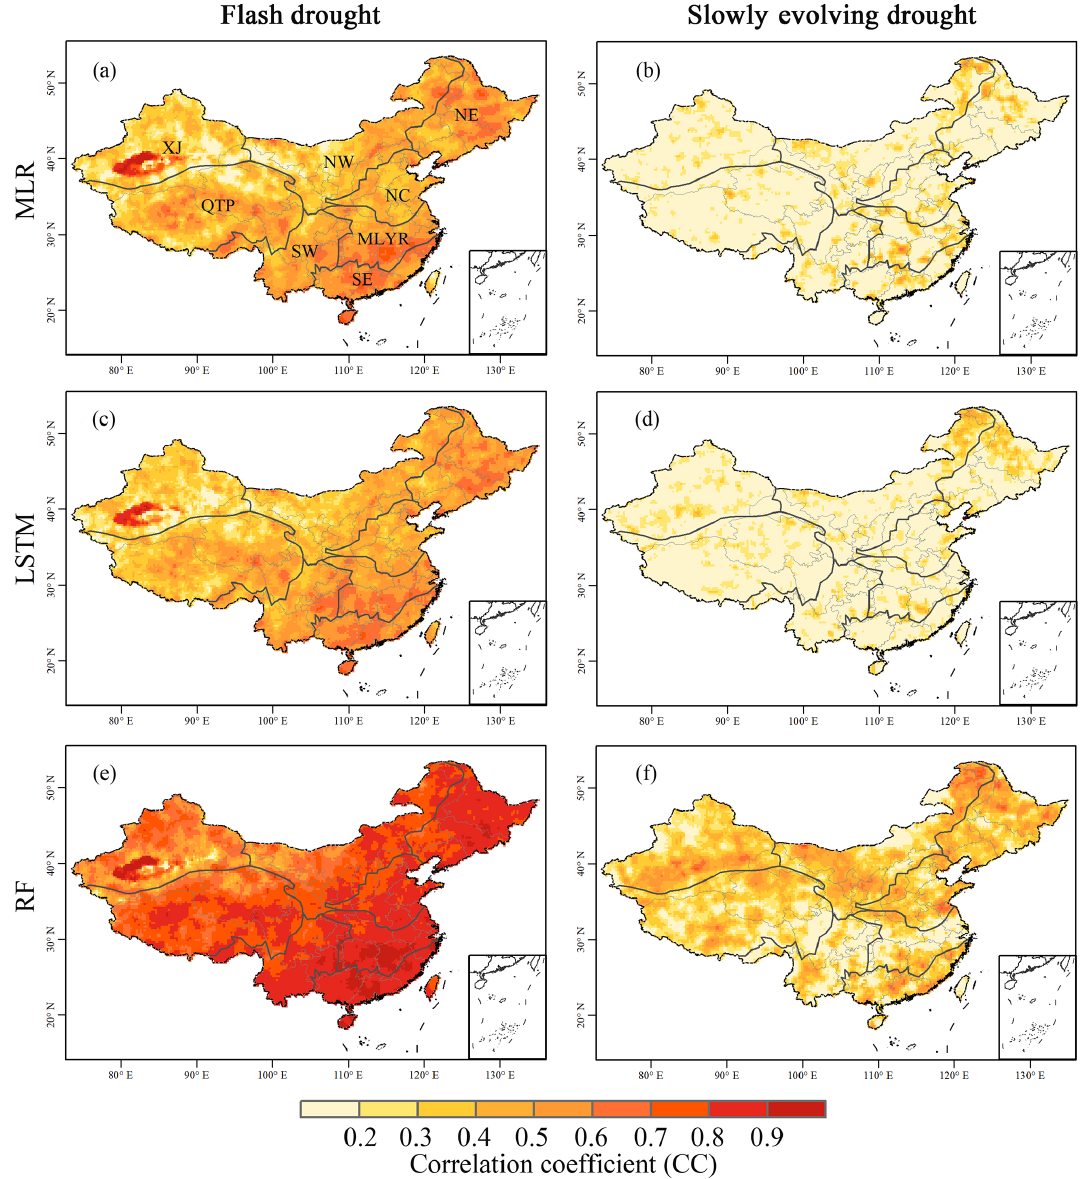
Figure 6. Spatial distribution of correlation coefficient (CC) of the rate of intensification (RI) estimated by (a–b) MLR, (c–d) LSTM, and (e–f) RF models against the observed RI under flash droughts and slowly evolving